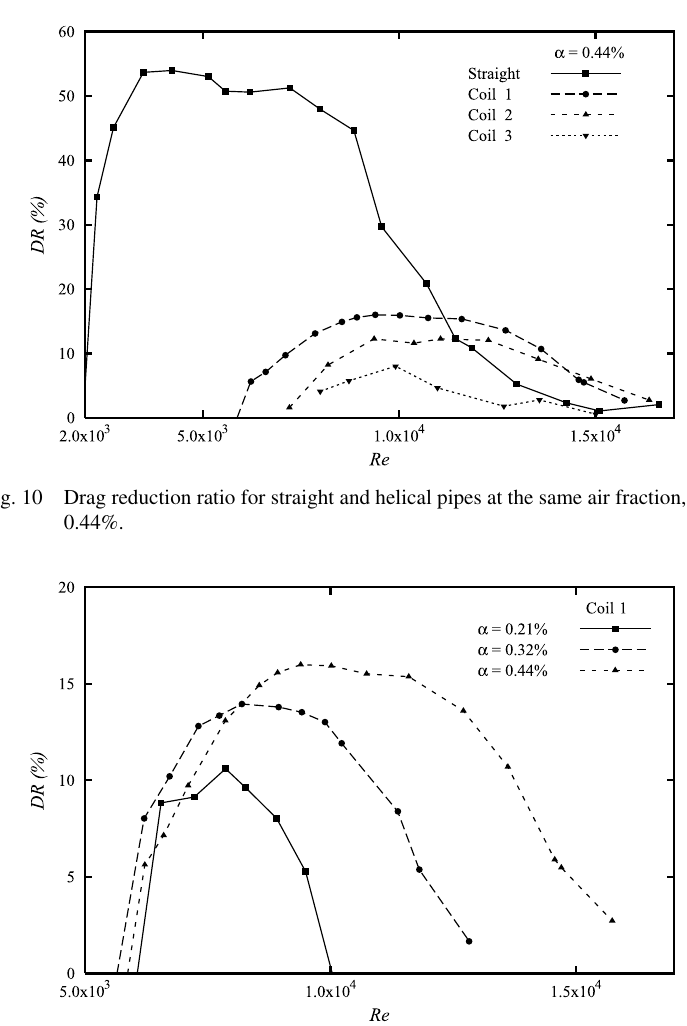
Fig. 11 Influence of air fraction on drag reduction ratio for helical pipe, δ = 0 .